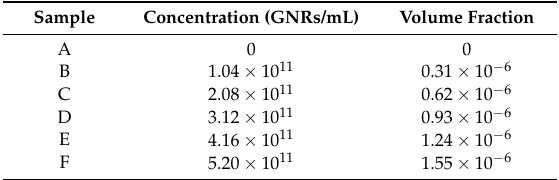
Table 1. Description of gold nanorods (GNRs) solution samples with various volume fractions.